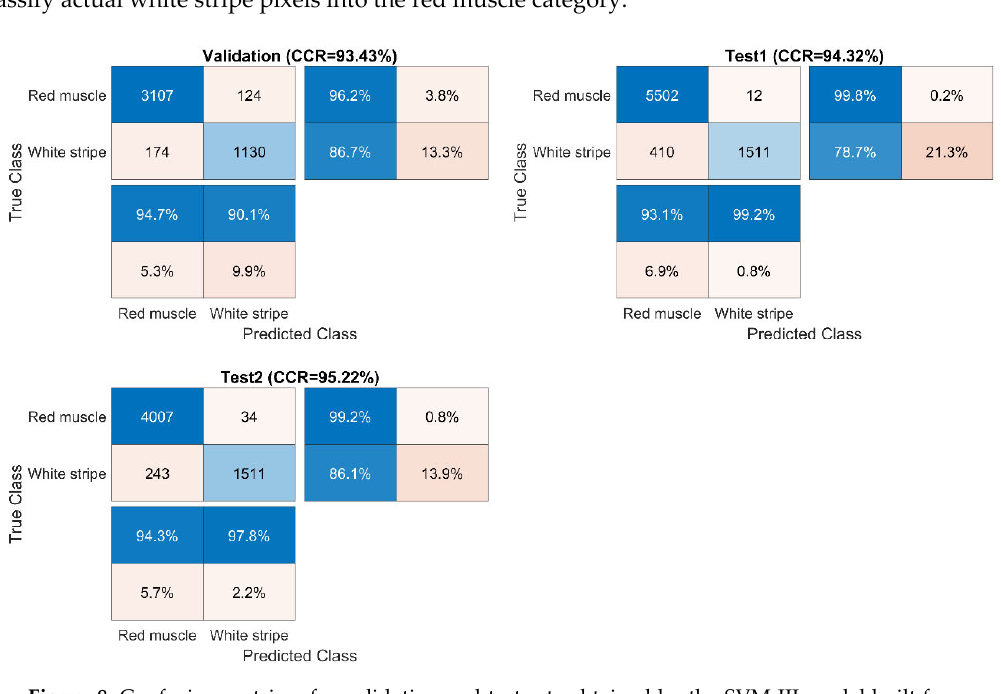
Figure 8. Confusion matrices for validation and test sets obtained by the SVM ‐ III model built from EPO pre ‐ treated